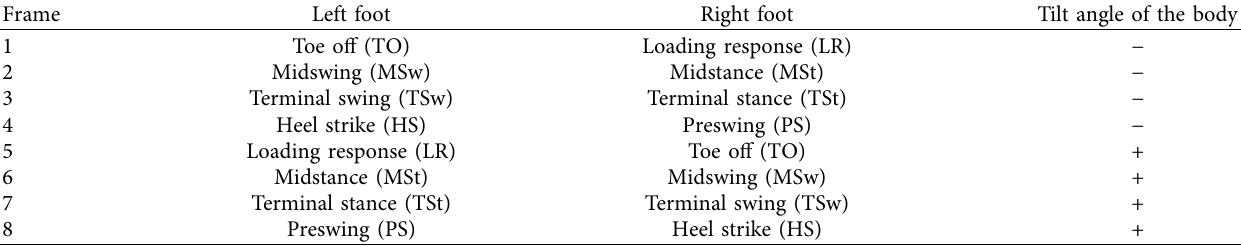
Table 1: Classification.